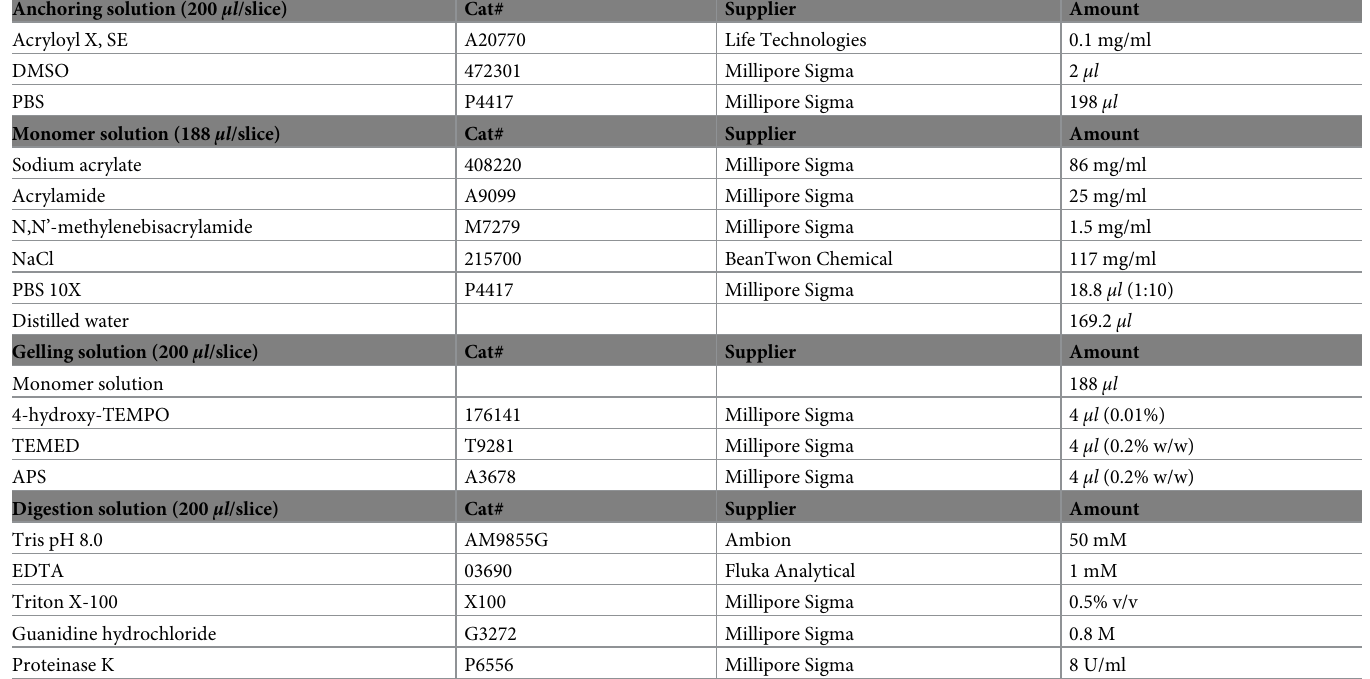
Table 2. Composition of anchoring, gelling and digestion solution for proExM. The tables list the chemical reagents that were used to process hippocampal slices for proExM. Anchoring solution (200 μl